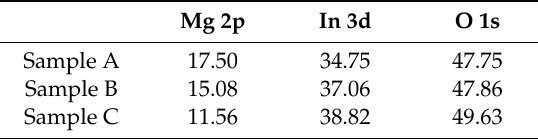
Table 3. Elemental composition of the three samples.